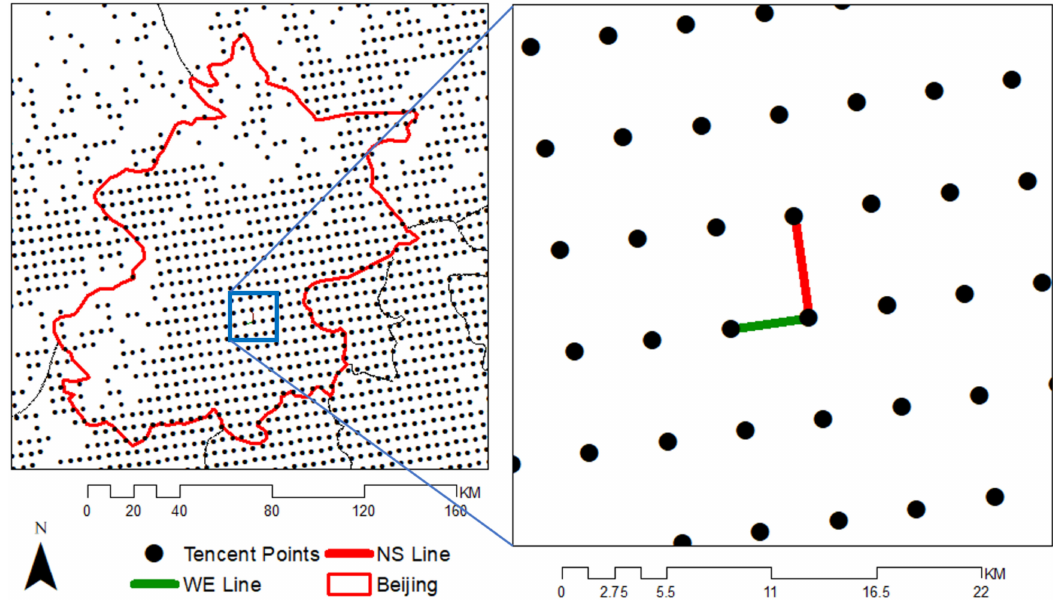
Figure 2. An example of the spatial structure of the Tencent positioning data for the Beijing